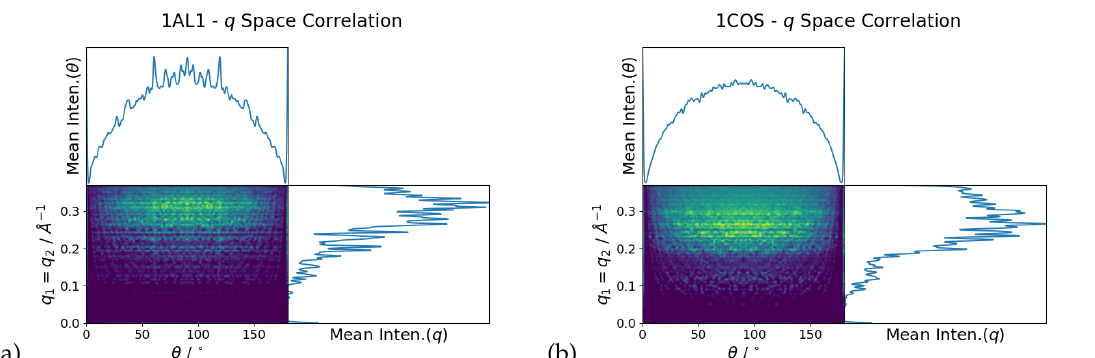
Figure 4. q -space correlations of ( a ) single helix protein (1AL1) and ( b ) three-helix bundle (1COS), generated from structure factors. The plot intensity has been scaled to the power of 0.25, and convolved with a Gaussian blur, with full width at half maximum (FWHM) of 6.8 10 − 3 Å − 1 by 2.3 ◦ . Scaling × allows highlighting of the lower intensity peaks, and the blur allows the small peak areas to become more visible. All of the intensity values are then scaled between 1 and 0 for the maximum and minimum values. Line plots above and right of the images show average intensity through each